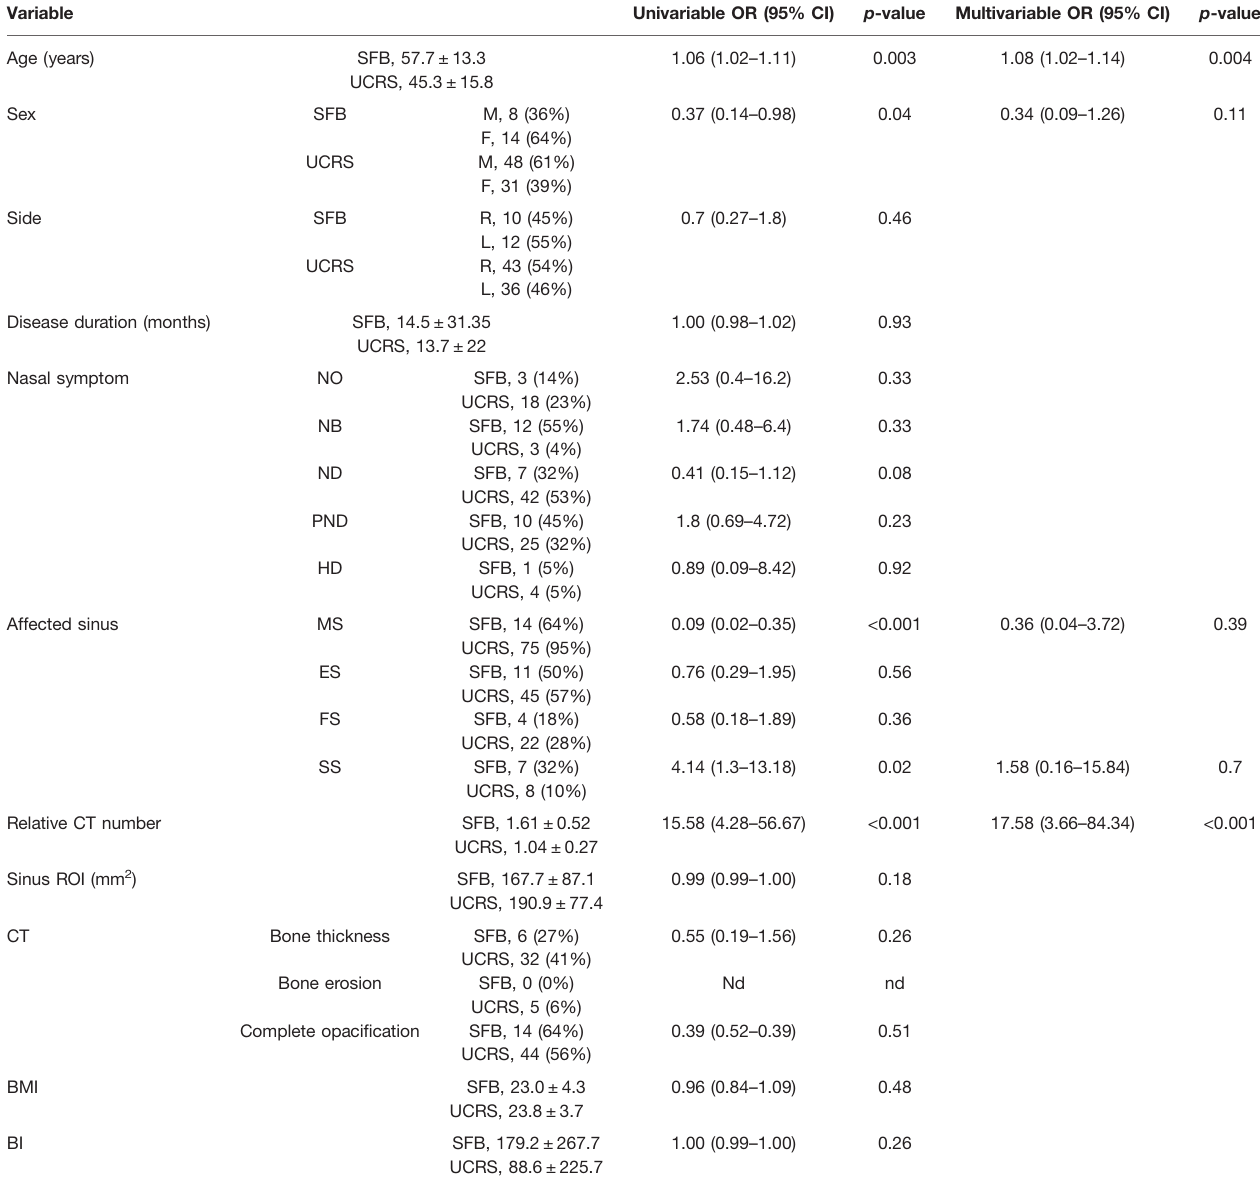
TABLE 4 | Univariable and multivariable analyses of factors predictive of SFB without calci fi cation (SFB, 22 cases; UCRS, 79 cases; N =101).